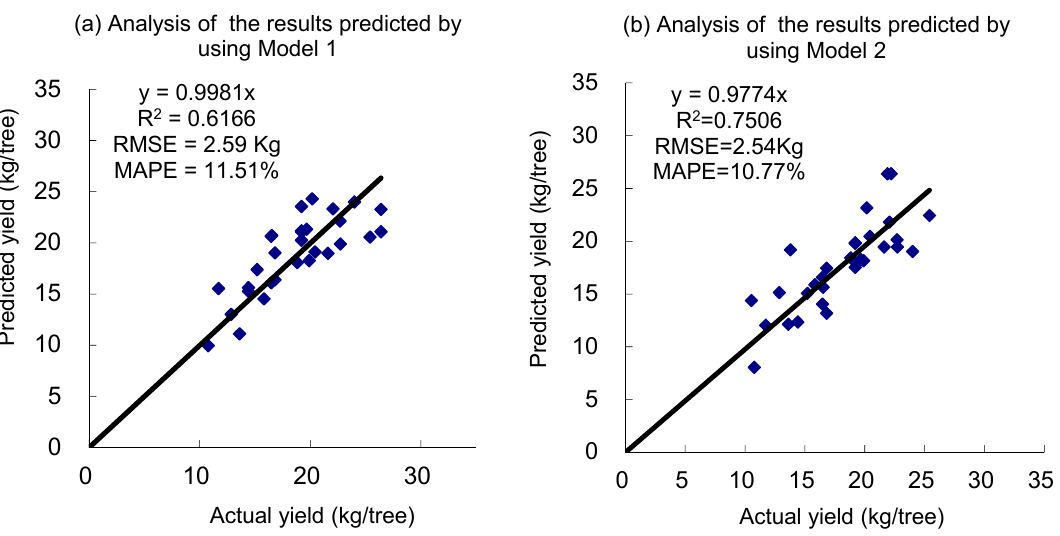
Figure 6. Yield prediction for 2011 based on ( a ) “Prediction Model 1” for young apple fruit in July and ( b ) “Prediction Model 2” for ripe apple fruit in September for the subsequent year ( n = 30 trees).